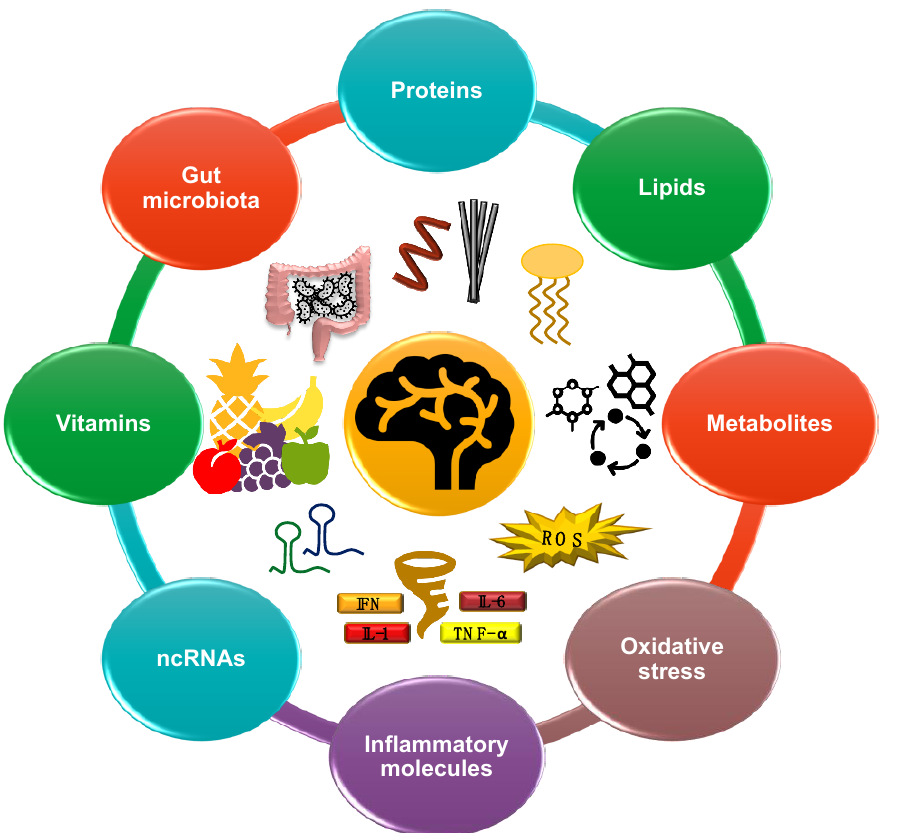
Figure 1. Classification of AD biomarkers. The figure illustrates the classes of blood-based AD biomarkers discussed in this review: long-studied and well-known proteins, inflammatory molecules, lipids, metabolites, oxidative-stress-related molecules, non-coding RNAs, vitamins, and gut-microbiota-based circulating molecules.